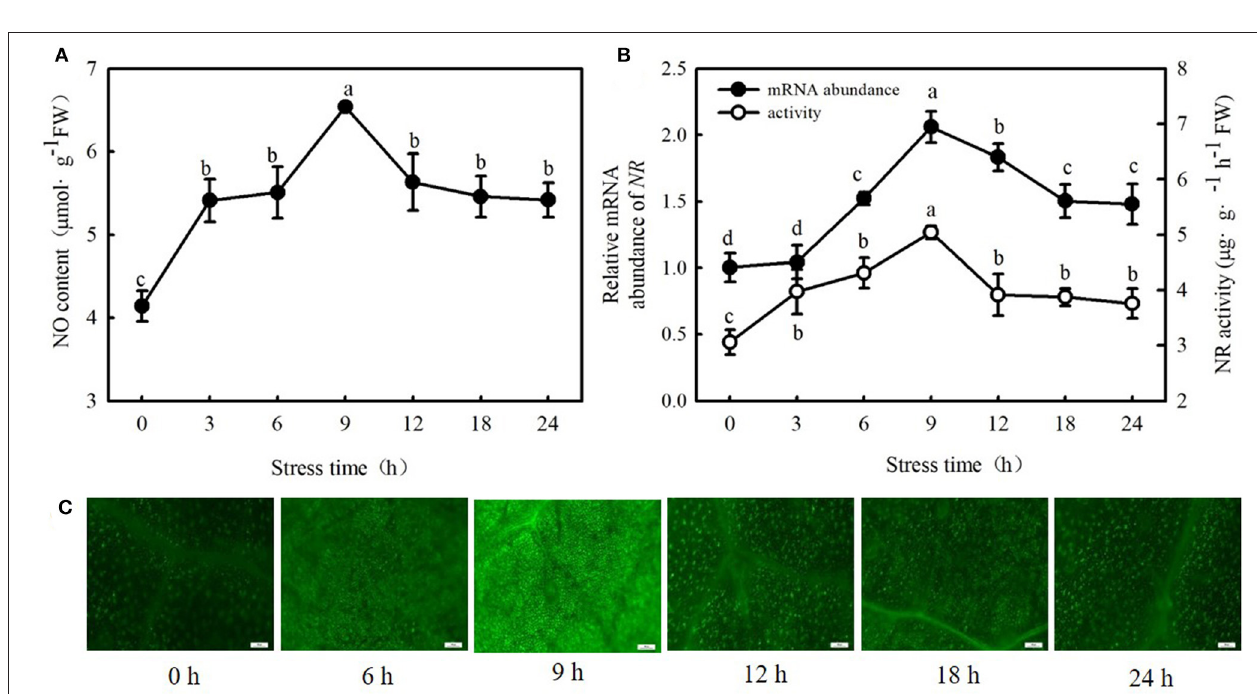
FIGURE 5 | Response of NO, activities, and relative mRNA expressions of NR to cold stress in cucumber seedlings. (A) NO content; (B) NR activity and NR- relative mRNA expression; and (C) NO inverted fluorescence microscope imaging. Seedlings were treated at 5 ◦ C for 24h, and sampled every 3h. Data are represented as mean ± SD ( n = 3). Different letters indicate a significant difference between samples according to Duncan’s new multiple range test ( p < 0.05).